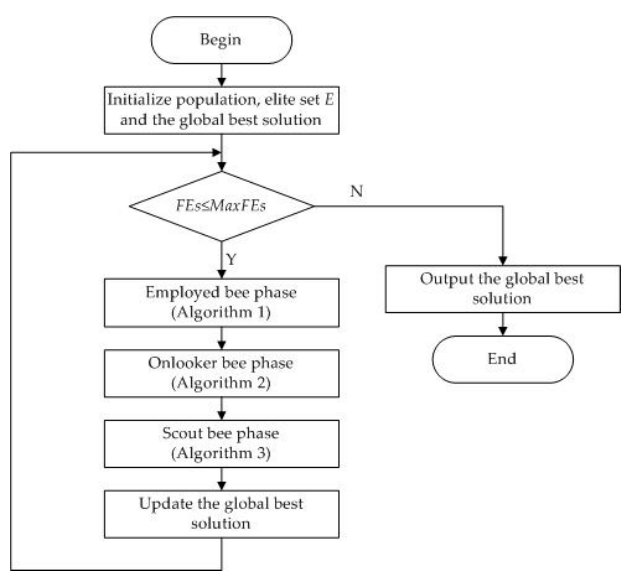
Figure 1. The flowchart of the proposed artificial bee colony-elite strategy and dimension learning (ABC-ESDL) algorithm.